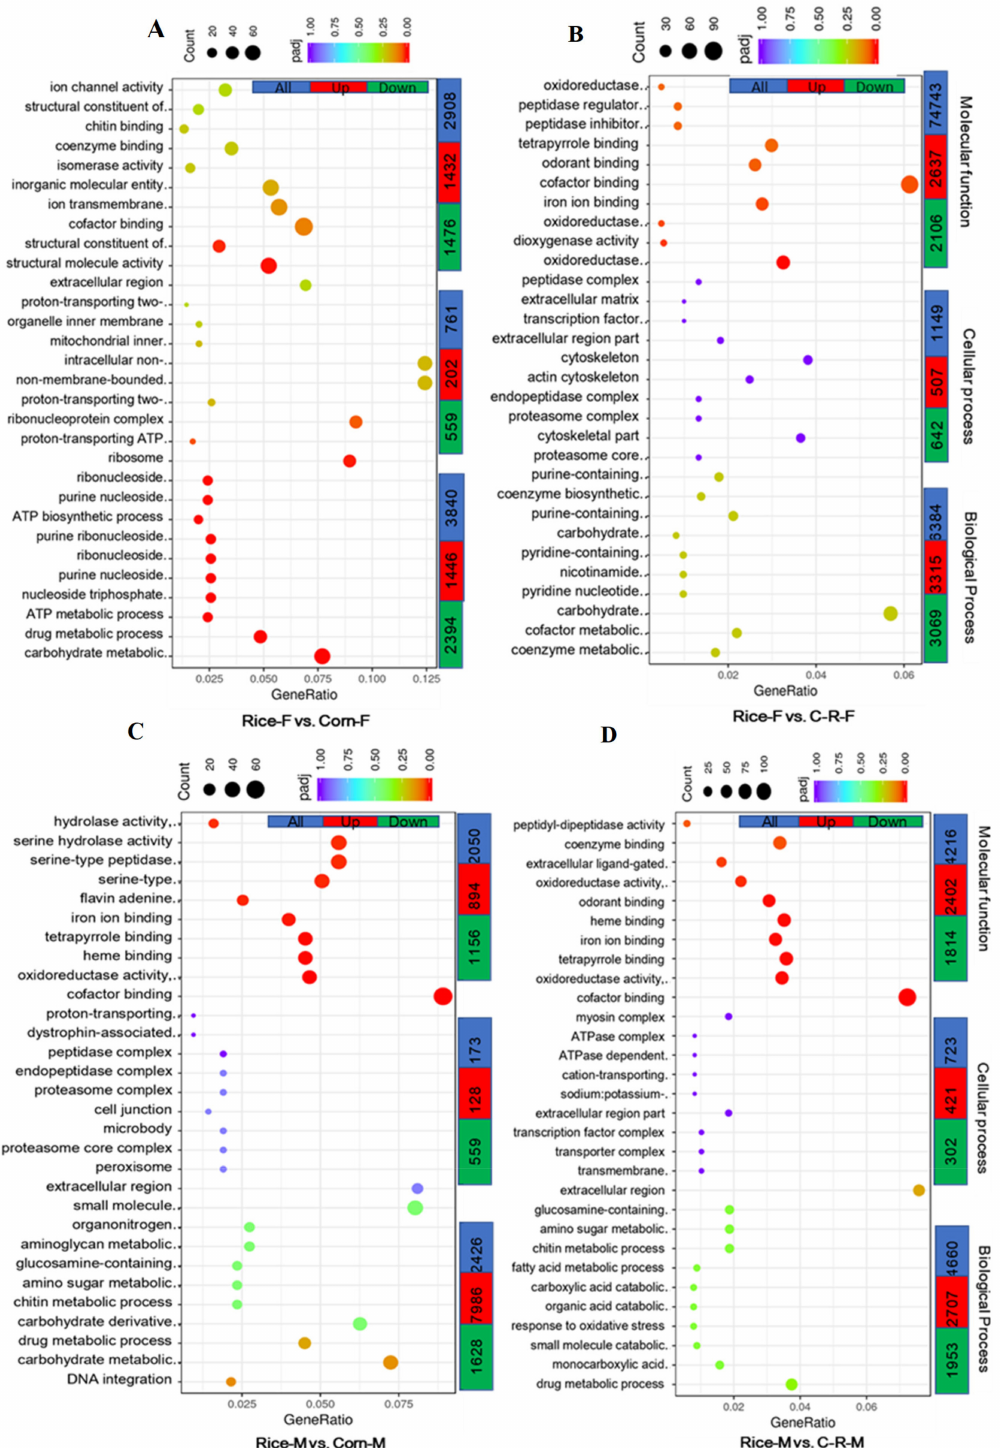
Figure 9. Gene Ontology (GO) classification of transcripts of Female (F) and Male (M) antennae. The number of significantly up- and down-regulated unigenes are assigned into three main ontologies: biological process, cellular component and molecular function in the Rice-F vs. Corn-F ( A ), Rice-F vs. C-R-F ( B ), Rice-M vs. Corn-M ( C ) and Rice-M vs. C-R-M antennae ( D ) (After 20 generation of selection the corn population was fed on rice for one generation (C-R-male)) of Spodoptera frugiperda when reared on corn and rice plants for 20